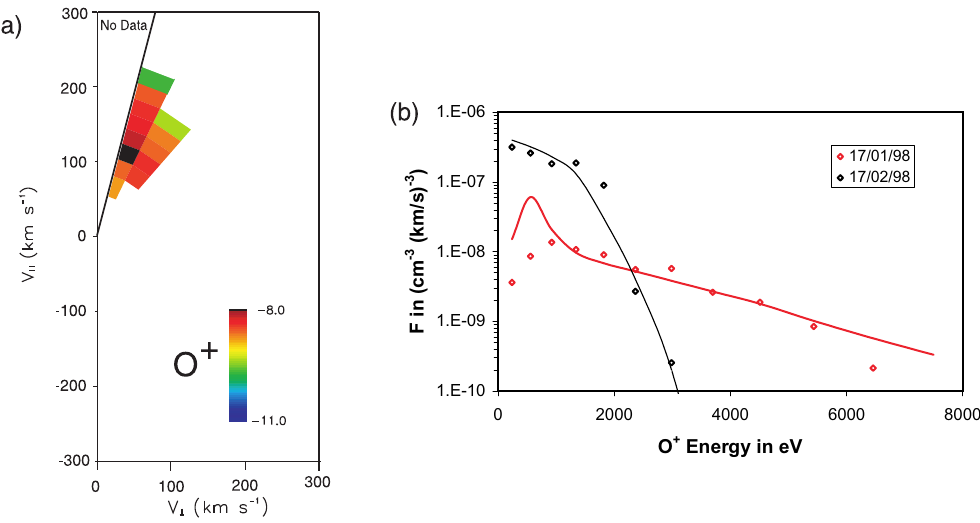
Fig. 13. (a) O + distribution function measured by the ION experiment on 17 January 1997, around 21:39 UT; (b) energy cut of the distribution in the direction of the peak